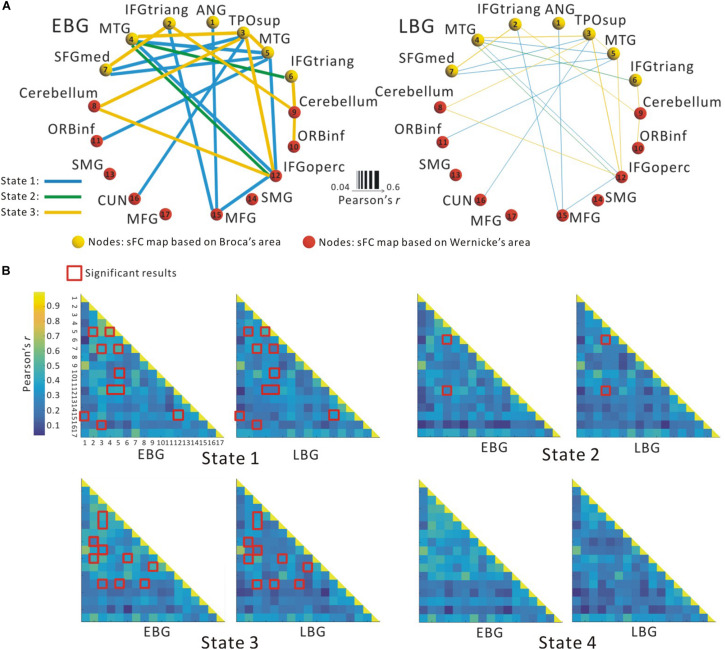
The dynamic functional connectivity (dFC) of the language network for both the early bilingual group (EBG) and the late bilingual group (LBG). (A) dFC of the language network in the subject group. The EBG had significantly higher dFC than the LBG (p < 0.05, FWE-corrected). (B) dFC of the language network for both the EBG and the LBG in each dFC state. The red boxes show significantly higher dFC in the EBG than the LBG (p < 0.05, FWE-corrected).